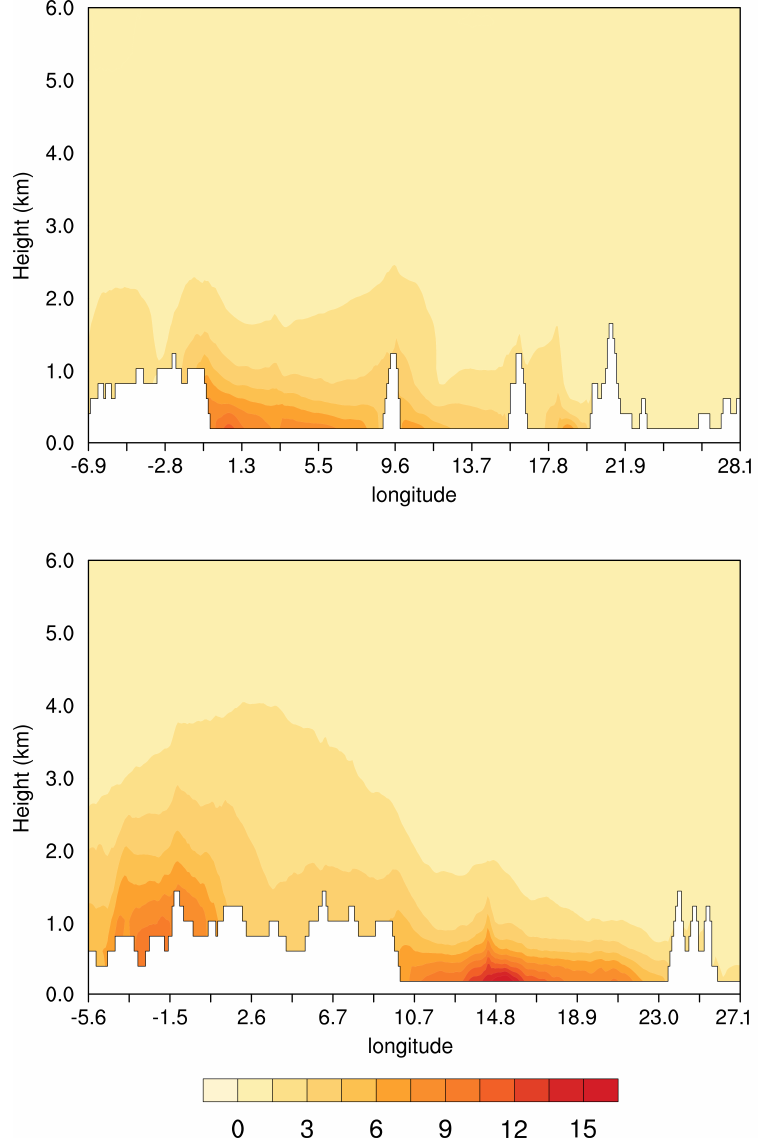
Figure 8. The vertical profile of the difference Tot_Emiss − No_ships (in ppb) to the O concentration along ≈ 39 ◦ N ( top ) and ≈ 34 ◦ N ( bottom ). The values are the average for the whole simulation period (5 to 27 August